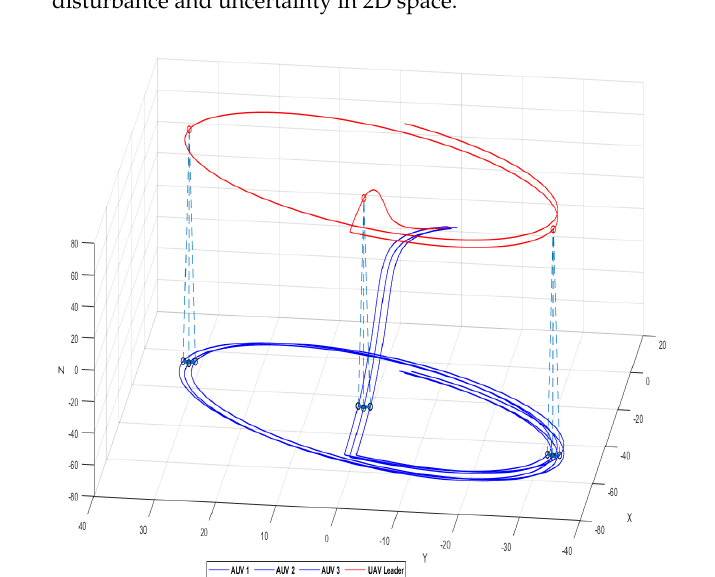
Figure 5. The formation control of three AUVs in triangle form with their UAVs leader under disturbance and uncertainty in 3D